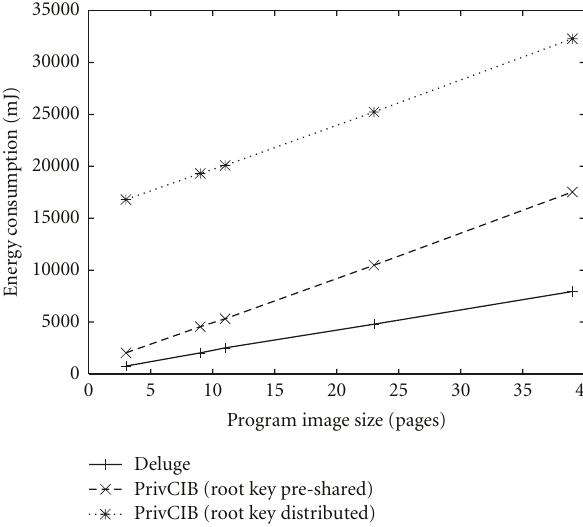
Figure 4: Transfer time from Base-Station to one node.